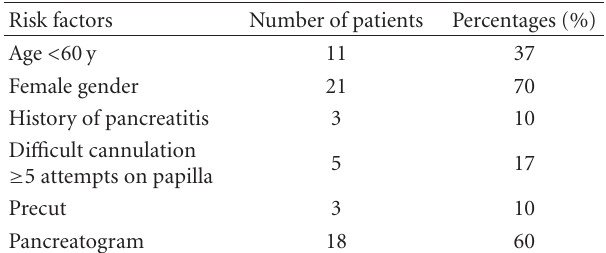
Table 2: Risk factors for the development of post-ERCP pancreati-